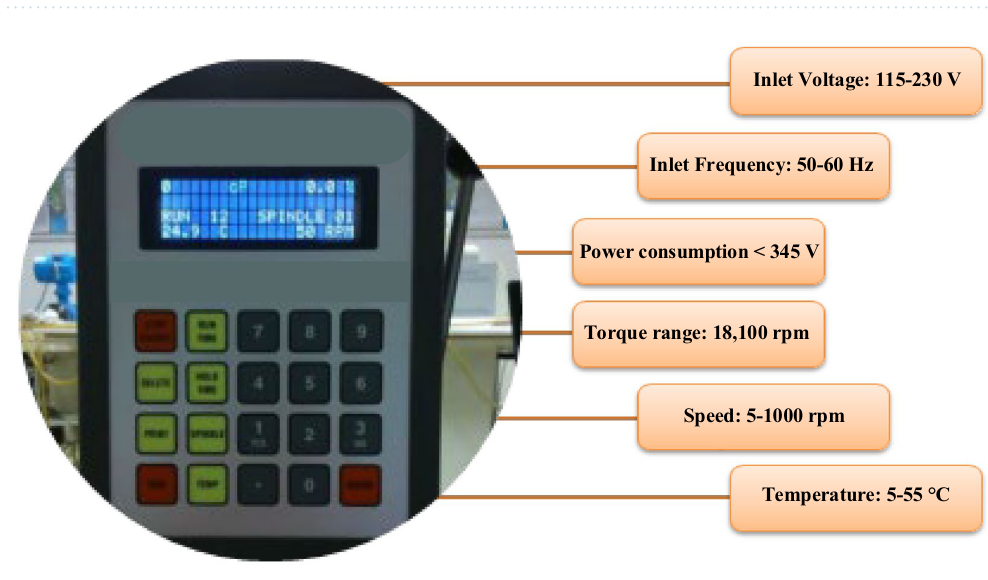
Figure 5. Brookfield viscometer model CAP2000+ and its technical